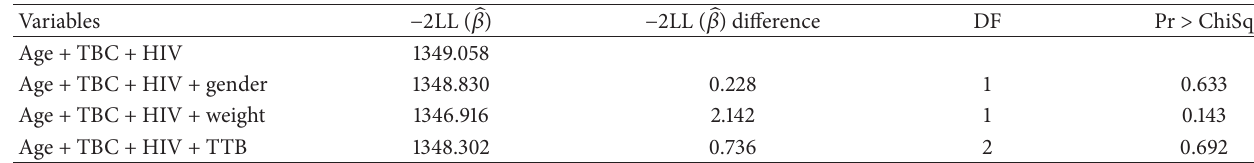
Table 5: Result of partial likelihood ratio test for those variables not significant in the univariable analysis fitted by being included in the model containing those variables significant in multivariable analysis one at a time.